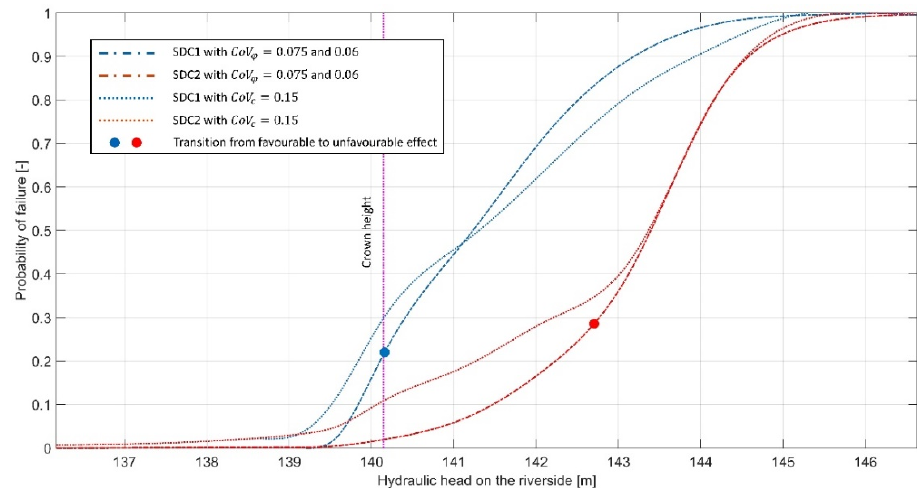
Figure 9. Fragility curves for variability of reduced strength parameters.